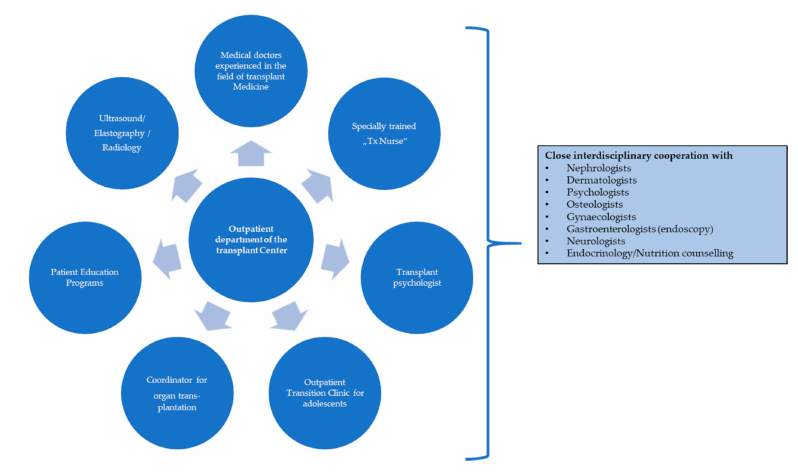
Figure 4. Setting up an interdisciplinary network at transplant outpatient clinics. Tx, transplant.